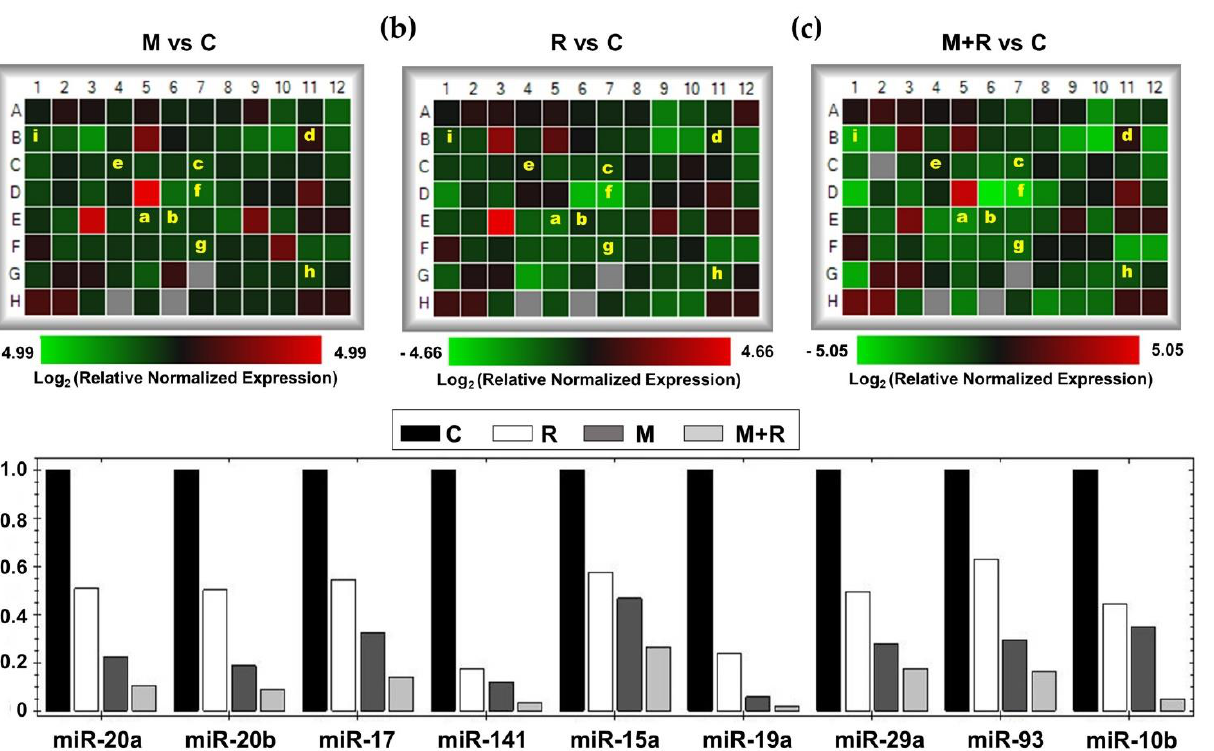
Figure 4. Effects of melatonin and radiation on breast cancer miRNA expression microarray. Total RNA from MCF-7 cells was extracted 4 h after radiation, reverse transcribed and used for RT-PCR analysis using Human Breast Cancer microarray (MIHS-109ZA). ( a – c ) Heatmaps of relative normalized expression between different treatments ( a ) M vs. C; ( b ) R vs. C; ( c ) M + R vs. C; ( d ) Bar chart of relative normalized expression ( ΔCt ) of selected miRNAs. a: miR20a; b: miR-20b; c: miR-17; d: